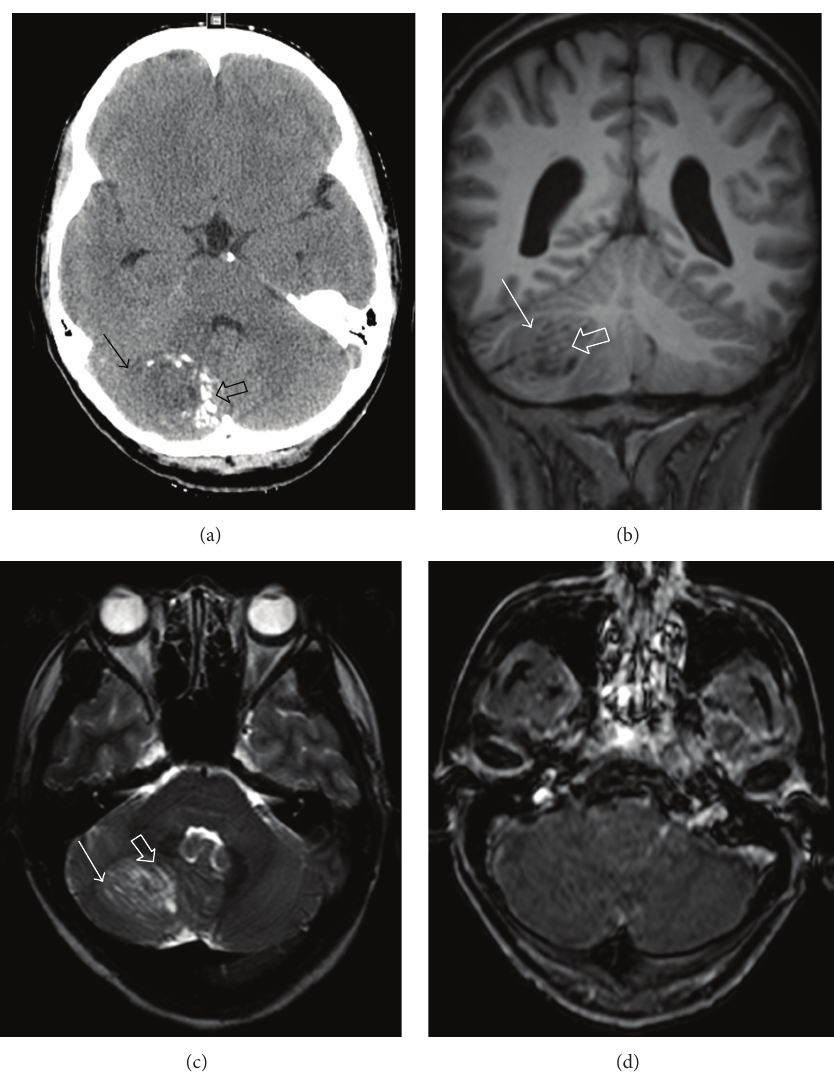
Figure 2: Noncontrast head CT (a) demonstrates a slightly hypodense (solid arrow) mass with calcifications (open arrow) centered in the right cerebellum. MRI of the brain demonstrates the typical striated-appearing right cerebellar mass with alternating isointense (solid arrow) and hypointense (open arrow) striations on coronal precontrast 𝑇 1 weighted image (b) and isointense (solid arrow) and hyperintense (open arrow) signal on axial 𝑇 2 weighted image (c). There is no appreciable enhancement of the mass on postcontrast axial 𝑇 1 weighted image